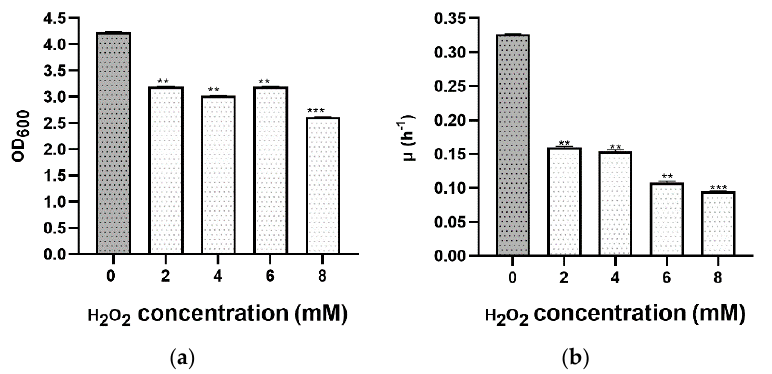
Figure 4. Effect of oxidative stress on the growth profile of Hfx. mediterranei R4 grown in Hm-DM. Data are based on three independent cultures. ( a ) Maximum OD 600 in stationary phase (reached at different times). ( b ) Average growth rate. Plotted values are the mean of triplicate measurements, and error bars represent ± SD. ** p ≤ 0.01; *** p ≤ 0.001. In grey, the control without H 2 O 2 ; in white, with H 2 O 2.